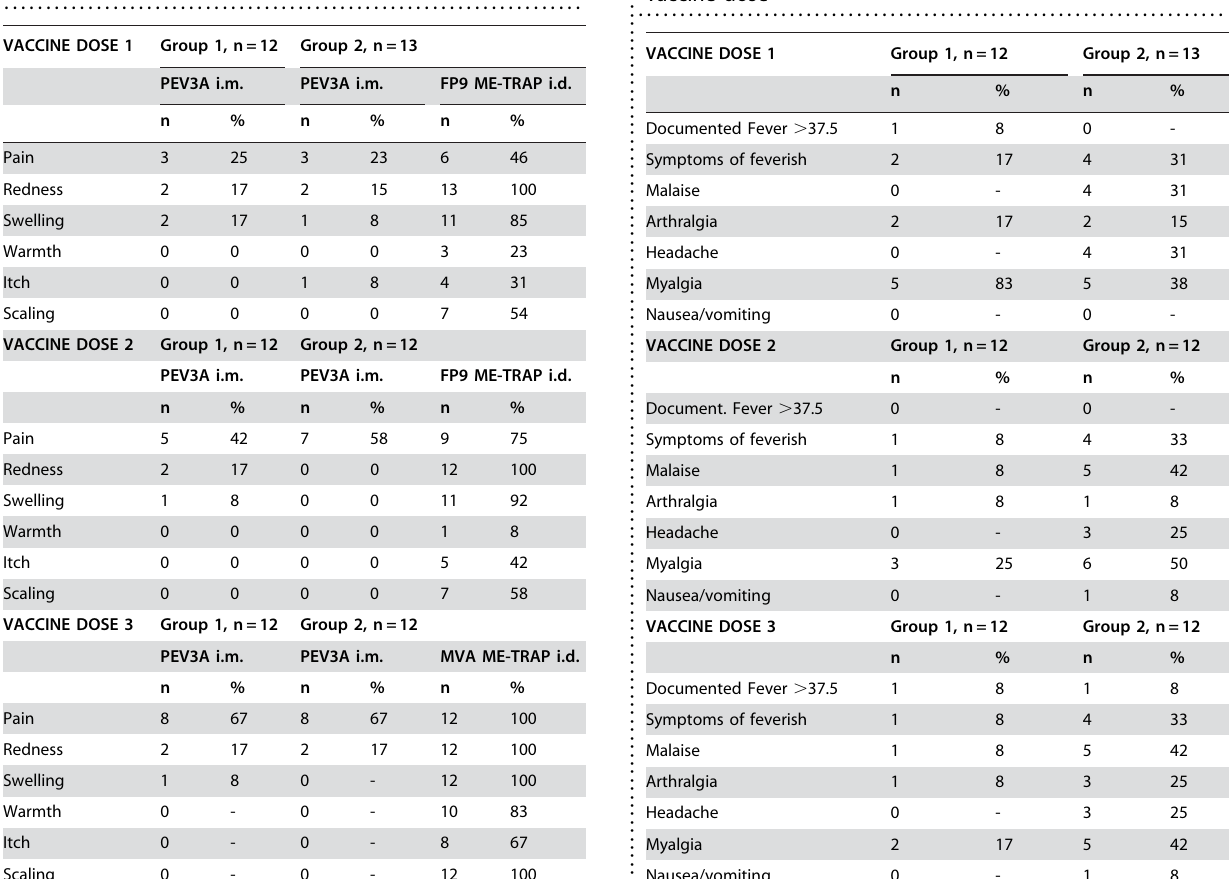
Table 2. Frequency of solicited local symptoms after each